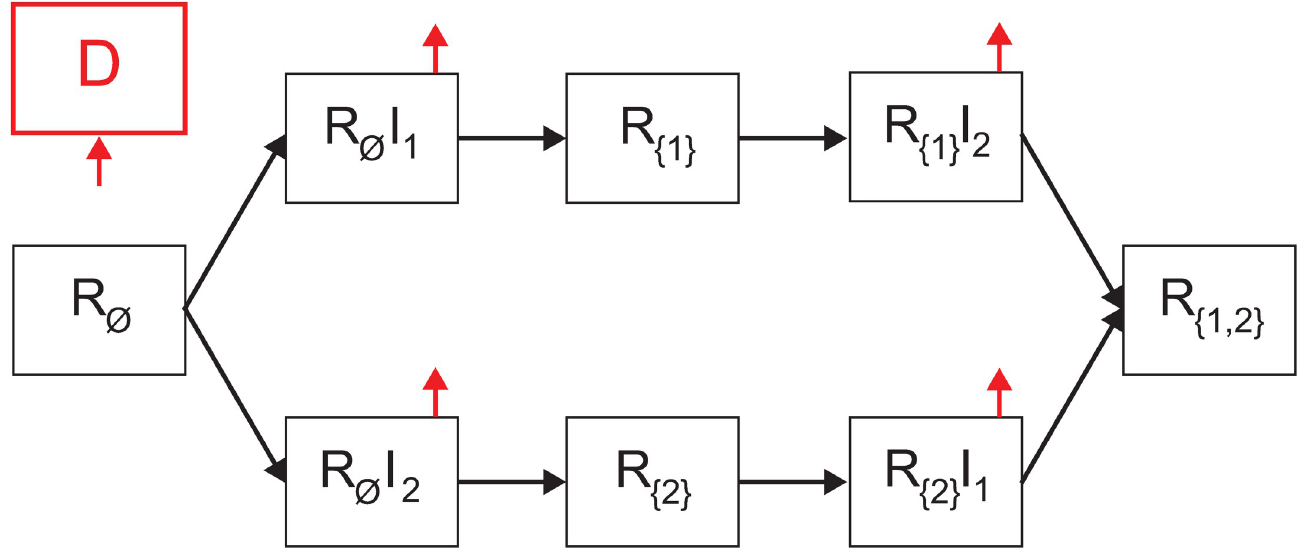
Fig 5. Schematic view of transition between disease stages in the case where | M | = 2.